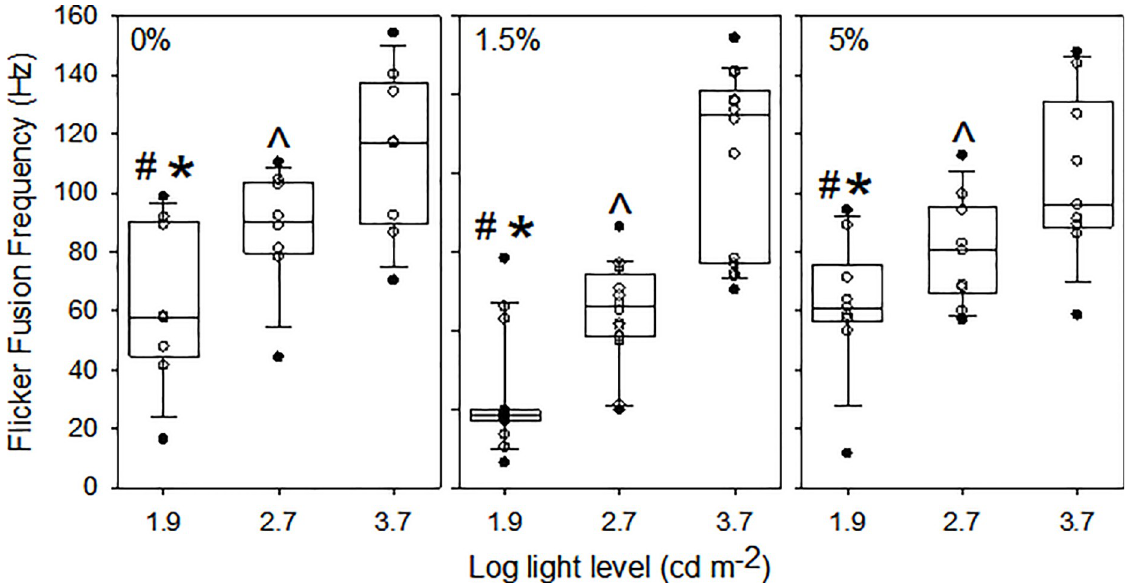
Fig 6. Flicker fusion frequencies (i.e., the highest frequency of sinusoidal light stimulus detectable) with increasing light intensities of European seabass. The light levels used correspond to approximately those needed to produce responses approximately 25%, 50% and 75% of the maximum response in the intensity–response curves (Fig 3). The solid lines within the boxes mark the median values, the boundaries of the boxes the 25 th and 75 th percentiles, and the whiskers (error bars) above and below the boxes the 90 th and 10 th percentiles. Data points between the 90 th and 10 th percentiles are shown as open circles and those outside this interval as filled circles. The symbols #, � , and ^ indicate differences in flicker fusion frequencies between log light levels 1.9 and 2.7, between log light levels 1.9 and 3.7, and between log light levels 2.7 and 3.7,